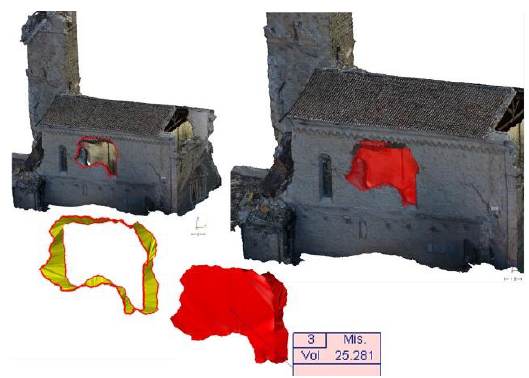
Figure 11. 3D analysis on West wall. a) Fitting plane analysis. b) t1-t2 comparison and mapping c) cracks mapping.